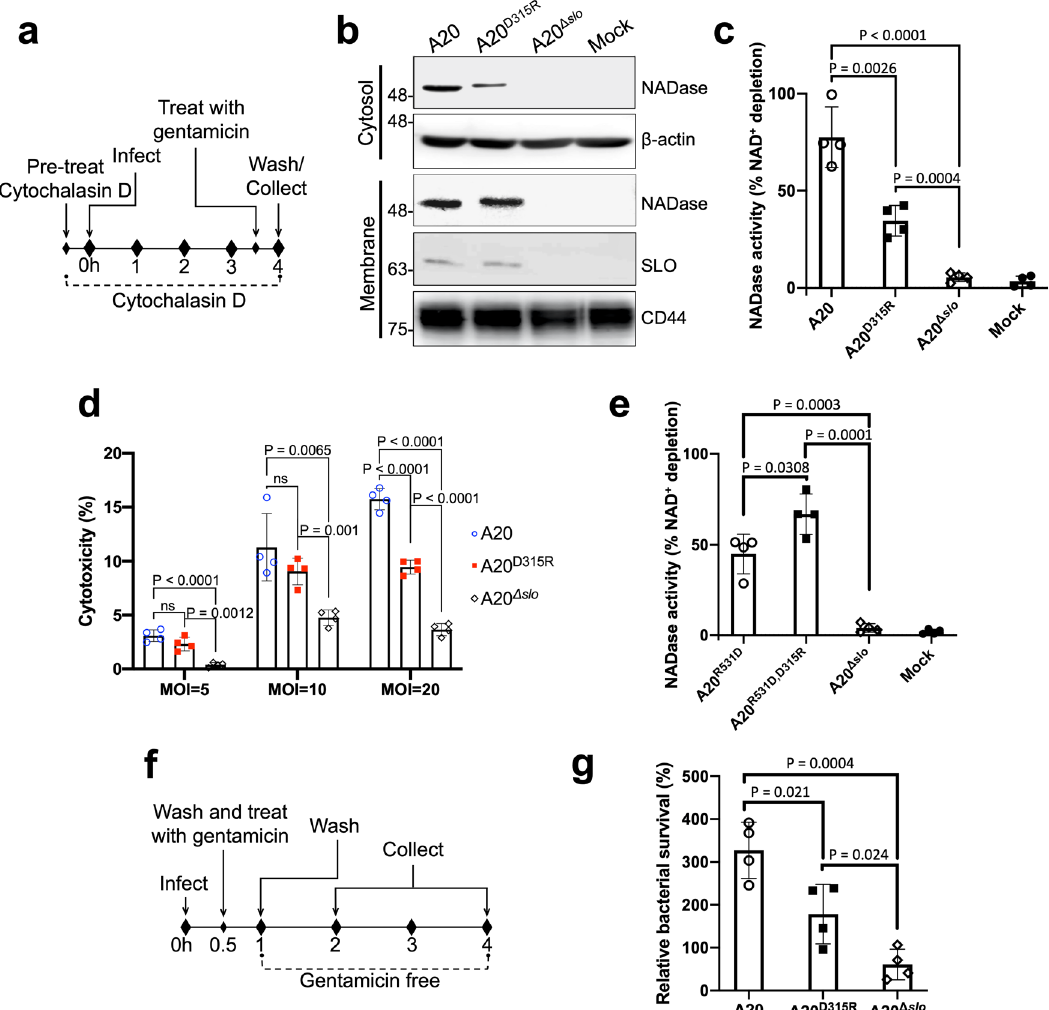
Fig. 4 The impacts of the NADase-SLO interaction on the CMT-mediated cytotoxicity of GAS and the bacterial survival within immune cells. a The schematic protocol for analyzing CMT-mediated translocation of NADase. A549 cells were pretreated with the micro fi lament inhibitor cytochalasin D to block bacterial entry 26 , followed by infection with A20, A20 D315R , or A20 Δ slo at an MOI of 5. b Immunoblot analyses of cytosolic (intracellular) and membrane fractions harvested from the GAS-infected A549 cells. Immunoblots were performed with antibodies against the proteins indicated on the right. β -actin (cytosol) and CD44 (membrane) were included as loading controls. c Intracellular NADase activity. The levels of NADase translocated into A549 cells were quanti fi ed by measuring cytosolic (intracellular) NADase activity of the GAS-infected A549 cells. d Cytotoxicity of GAS strains to A549 cells. The cytotoxicities of A20, A20 D315R , or A20 Δ slo on A549 cells were determined by measuring the activities of lactate dehydrogenase released from the cells infected by the strains for 4 h at indicated MOIs. Cytotoxicities are expressed as a percentage of lactate dehydrogenase released by uninfected cells lysed with 1% Triton X-100. e The effect of restoring the NADase-SLO interaction on NADase translocation. Intracellular NADase activities of A20 R531D - and A20 R531D,D315R -infected A549 cells were measured after the infection protocol described in Fig. 4a was performed. f Schematic protocol of GAS infection of phagocytic cells. PMA-activated U937 cells were infected with A20, A20 D315R , or A20 Δ slo at an MOI of 50. g Survival of the GAS strains in U937 cells. The number of surviving bacteria was counted by a CFU-based assay. The results are presented as percentages of the intracellular bacterial burden at 4-hour post-infection compared to those at 2-hour post-infection. The data are the representative of three biologically independent experiments performed in quadruplicate shown as mean ± standard deviation. The statistical signi fi cance was calculated by a two-tailed unpaired t (MOI) of 5 for assessing the translocation of NADase. A20 expresses wild-type NADase and SLO, while A20 D315R expresses the NADase D315R mutant and wild-type SLO. A20 Δ slo is an slo deletion mutant of A20 and thus does not express SLO. After 4 h of incubation, the intracellular NADase levels in A20 D315R - infected cells were signi fi cantly lower than in A20-infected cells and were undetectable in the A20 Δ slo -infected cultures (Fig. 4b). The corresponding intracellular NADase activity in A20 D315R - infected cells was signi fi cantly lower than that in A20-infected cells, while no activity was detected in A20 Δ slo -infected cells (Fig. 4c). In addition, the lower intracellular NADase protein